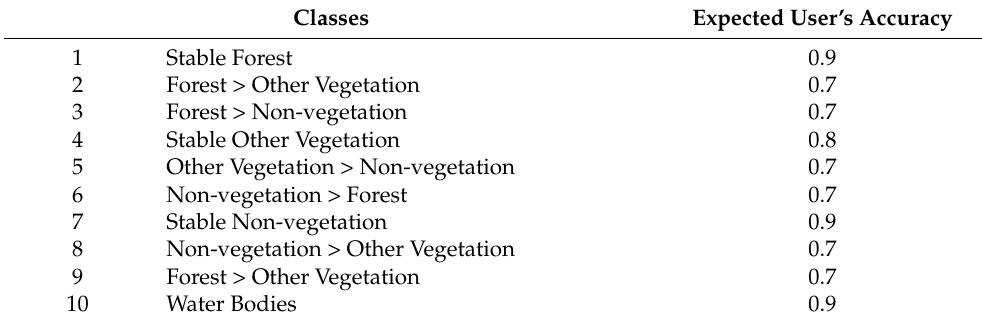
Table A2. The expected user